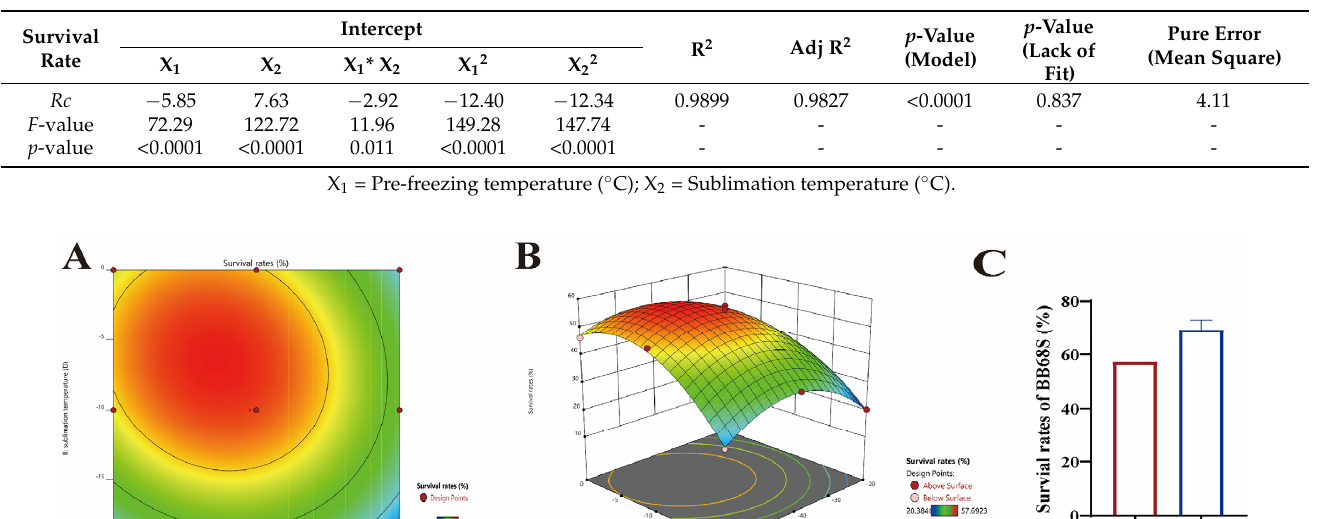
Table 2. Regression coefficients obtained by response surface methodology explain the effects of pre-freezing temperatures and sublimation temperatures on survival rates of Bifidobacterium longum BB68S.